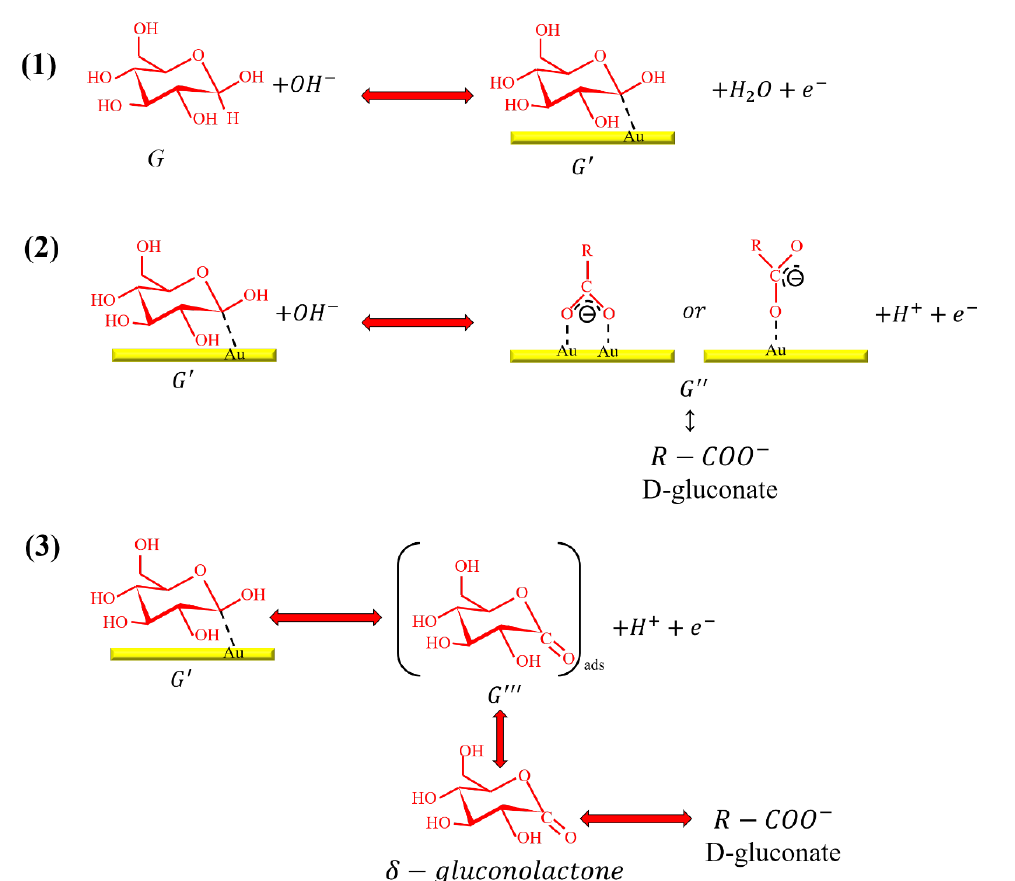
Figure 9. The schematic diagram of the reaction mechanisms of catalyzed glucose oxidation onto a gold surface. (1) Glucose is attached to gold electrode in alkaline solution. (2) To form D-gluconate by R-COO - bond (3) To transform D-gluconate to δ-gluconolactone.